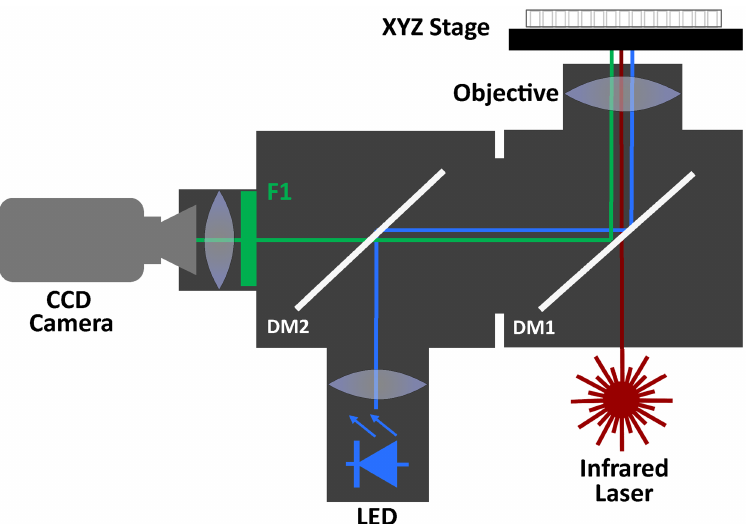
Fig 1. System diagram. Fully opticalhigh-throughput platform for measuring electrophysiological parameters in hCM monolayers with beatingrate control. A 96-wellplate sits atop an XYZ stage. Infrared laser light (1465 nm or 1860 nm) is directedto the center of a single well through a long pass dichroic mirror (DM1) and uncoatedcustom objective.Light from a high power LED (470 nm or 530 nm) is reflect by a second dichroicmirror (DM2) and DM1 to the same well. Fluorescence from the well is reflected by DM1 and passed by DM2 to filter F1 (535 ± 30nm) and focused onto a CCD camera.